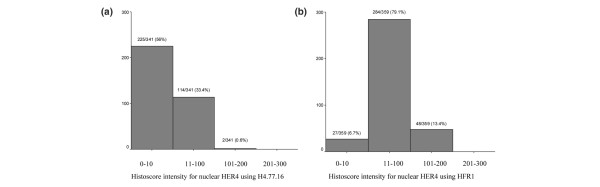
Frequency histograms for nuclear staining intensity using (a) H4.77.16 and (b) HFR1.